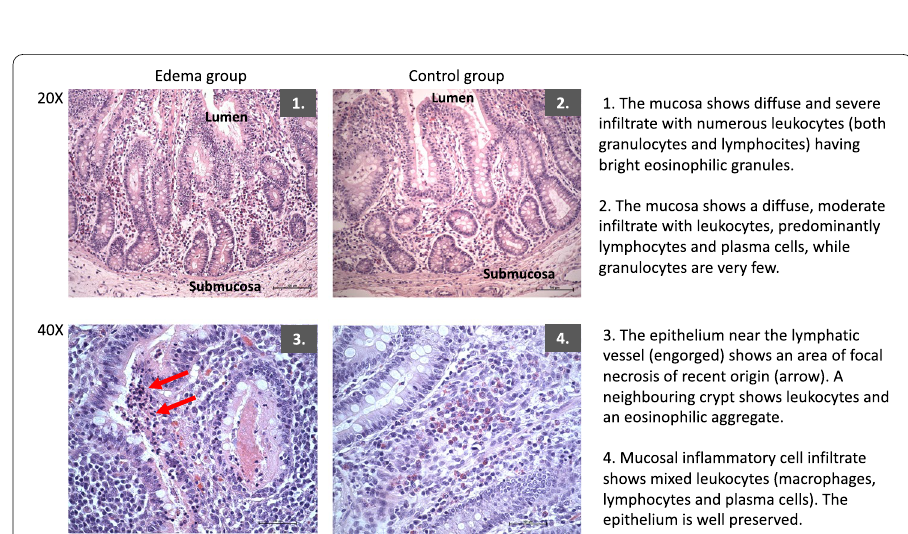
Fig. 5 Histopathological samples from duodenum. Even if not all the animals showed the same degree of edema and inflammation as those in the figure, the presented slides are representative and illustrate patterns found throughout the groups. In the 20 magnification the difference in the inflammation degree (the × amount and type of infiltrate) is shown. In the 40 magnification it is possible to see some recurrent pattern × in the Edema group, such as engorged lymphatic vessel and areas of focal